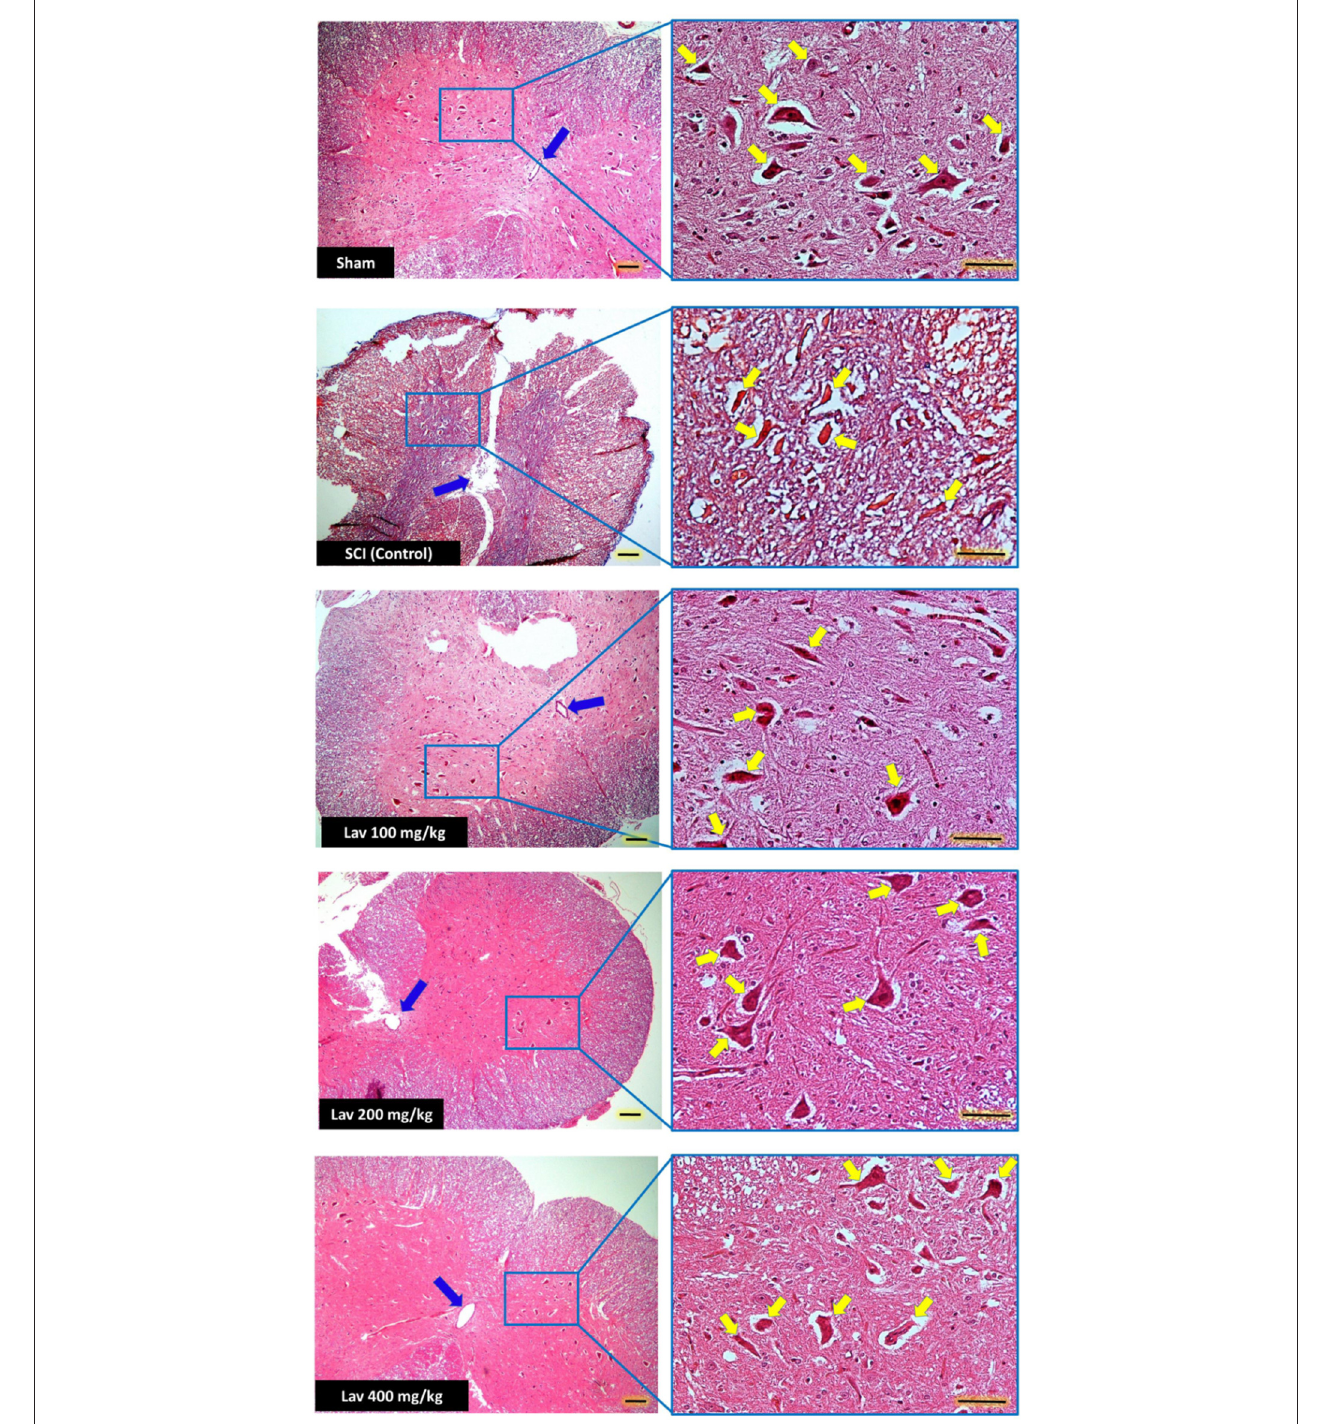
FIGURE 5 | Administration of L. angustifolia improved Histomorphological evaluation results in the rat spinal cord contusion model. Transverse section of spinal cord showing the ventral horn gray matter from spinal cord at the level of T12-L1 of all groups which evaluated in this study at day 56. H&E staining showed shrinkage and decrease of Ventral Horn Motor Neurons of control (SCI) in compare with Lav 100, 200 and 400 mg/Kg/Day. Yellow arrows illustrating the Ventral Horn Motor Neurons and blue arrows show central canal. L. angustifolia extract increased the number of VHMNs and improved the shape of central canal. Bar in 40X = 100 micrometer and Bar in 200X = 50 micrometer. (ECLIPSE 5Oi